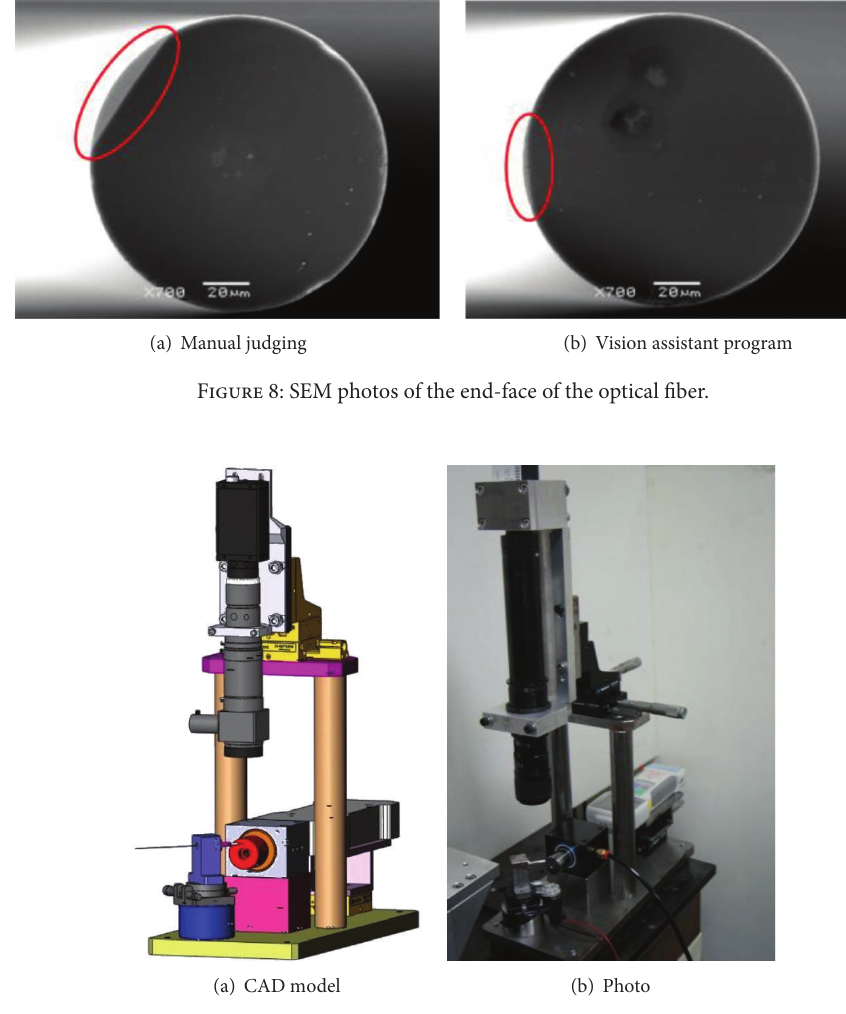
Figure 9: Contact force measuring